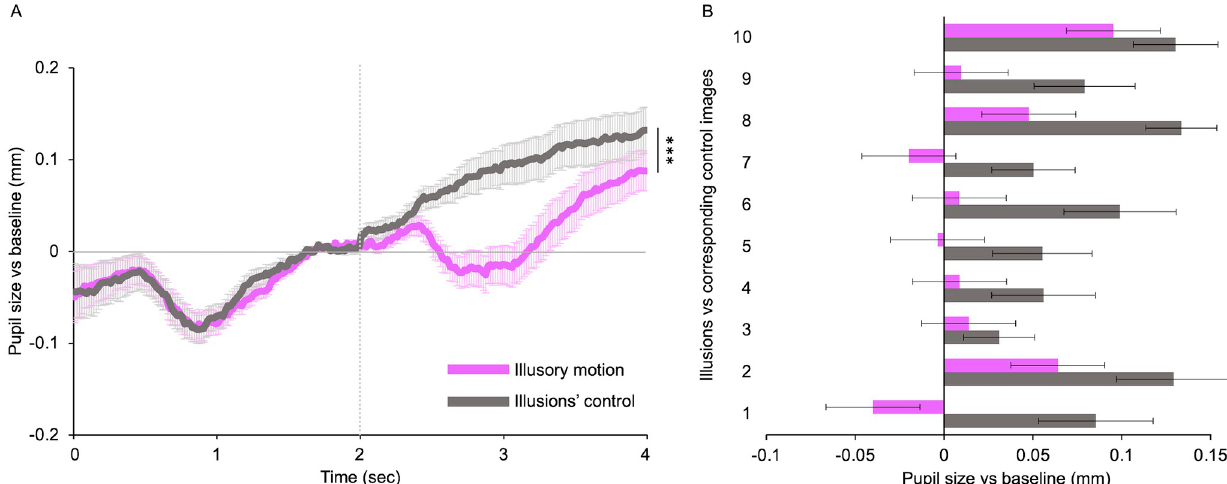
Fig 4. Control for illusory motion effect. (A) Baseline-corrected pupil size for illusory motion and illusions’ control, plotted as a function of time from trial onset. The horizontal line represents the baseline: data over the zero-line represent pupil dilation whereas data under the line represent pupil constriction. The vertical line indicates the stimulus onset. Error bars are SE. Asterisks mark statistically significant comparison across image categories: ��� p < 0.001. (B) Mean pupillary diameter for each illusion and the corresponding control image. Purple: motion illusions; grey: illusions’ control images. Error bars are SE.